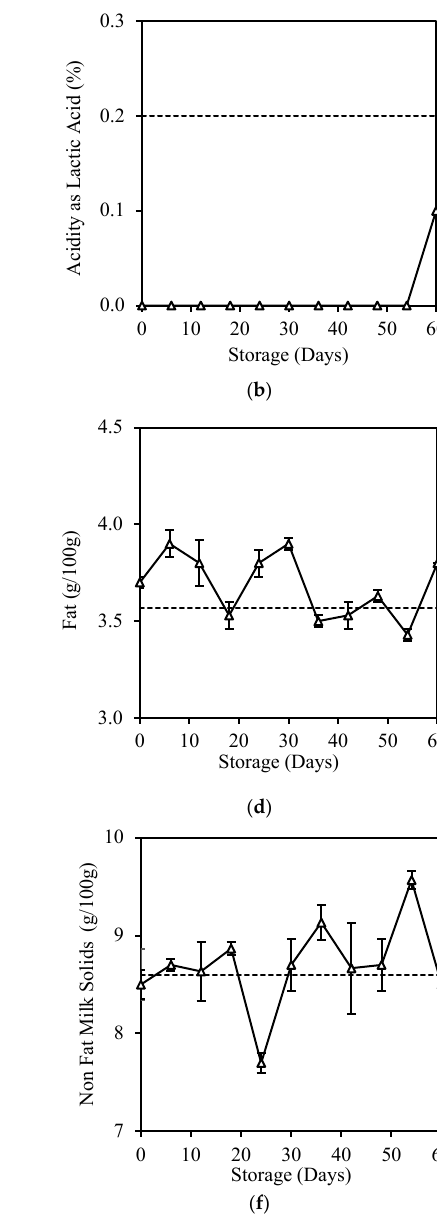
Figure 2. Changes in ( a ) pH, ( b ) Acidity as Lactic Acid, ( c ) Protein, ( d ) Fat, ( e ) Total Solid, and ( f ) Non-Fat Milk Solids of HPP milk during 60-day storage. Dotted lines represent the fresh milk before treatment.